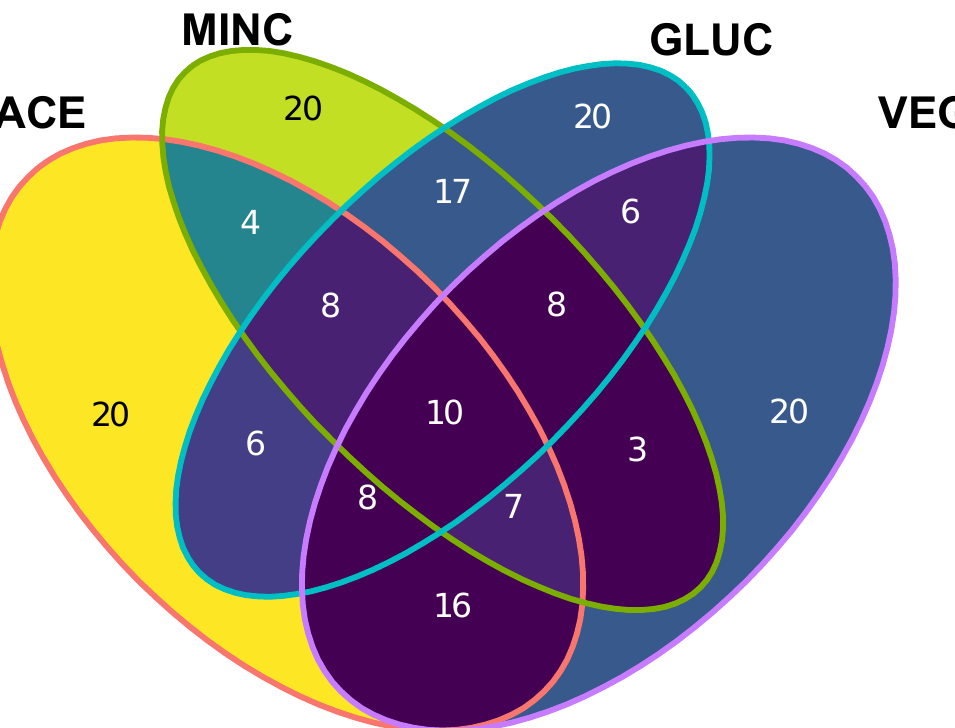
Figure 4. Venn diagram of identified peptides with their human target protein interactions. The numbers indicate independent subsets of shared peptides with the lowest binding free energy among molecular targets. Ten different peptides comprise the subset of multi-target directed ligands. Angiotensin converting enzyme (ACE), Mineralocorticoid receptor (MINC), Glucocorticoid receptor (GLUC), Vascular Endothelial growth factor (VEGF).